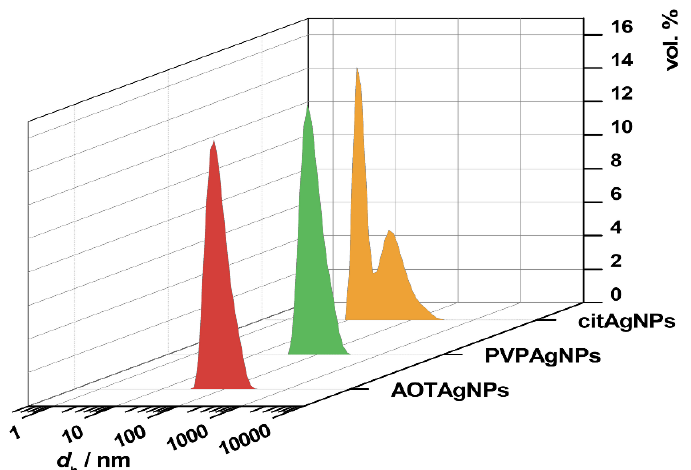
Figure 3. Representative volume size distribution of silver nanoparticles (AgNPs), stabilized with citrate (cit-AgNPs), poly(vinylpyrrolidone) (PVP-AgNPs), sodium bis(2-ethylhexyl) sulfosuccinate (AOT-AgNPs) suspended in anionic reactant solution ( c (Na 2 HPO 4 ) = 8 · 10 ‒ 3 mol dm ‒ 3 , γ (AgNPs) = 50 mg dm − 3 , pH 7.4) at 25 °C. d h —hydrodynamic diameter.